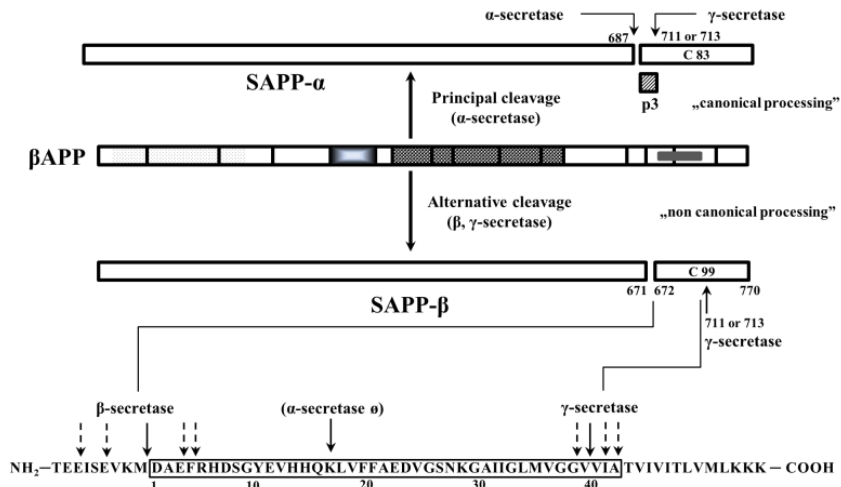
Figure 1. Simplified presentation of the amyloid precursor protein (APP) and its processing products. Principal cleavage of APP with α -secretase results in the formation of water soluble products (SAPP- α , C83 and P3). Alternative (amyloidogenic) cleavage with β - and γ -secretase gives a heterogeneous mixture of β -amyloid (A β ) peptides of 37 to 43 amino acids.